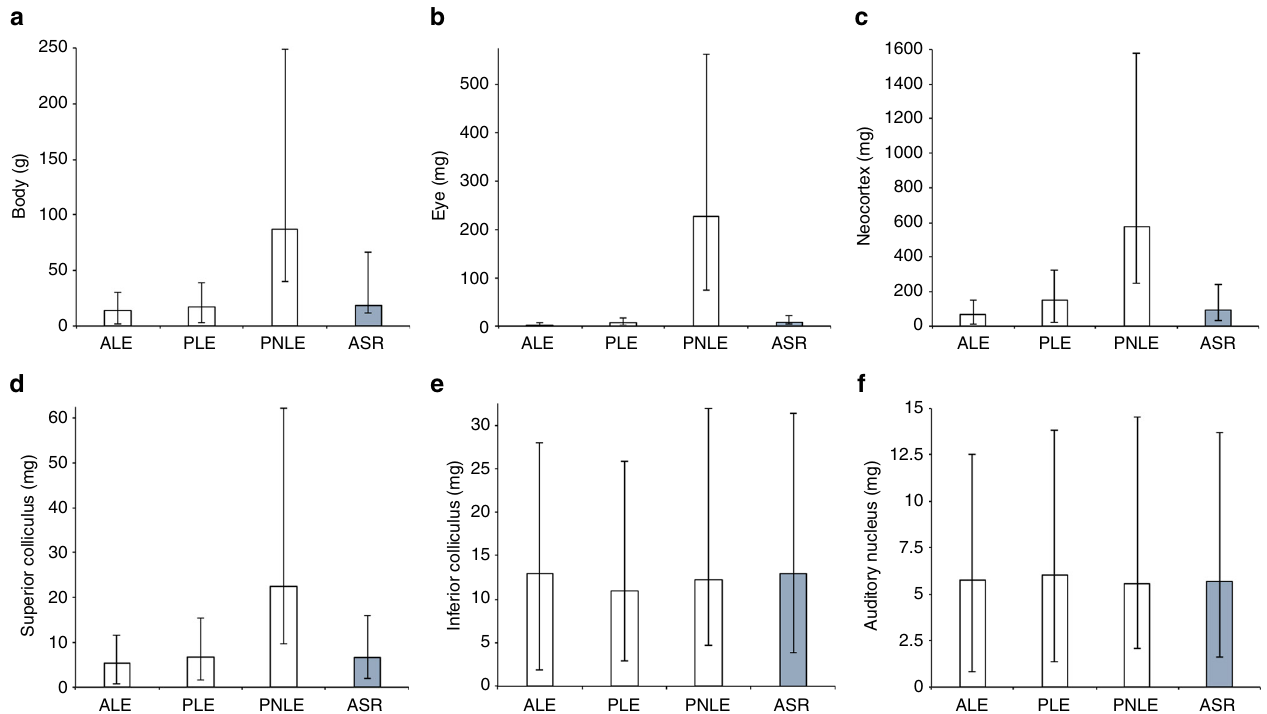
Fig. 3 The ancestral states of bats versus modern foraging categories. The ancestral states (maximum likelihood estimate of the root node) of six continuous traits considered in this study are shown with 95% con fi dence intervals. The tree was re-rooted at each internal nodes and contrasts state at the root was computed each time. AS estimate at the root compared to extant foraging categories for: a body mass ( N = 183), b eye mass ( N = 183), c neocortex mass ( N = 149), d superior colliculus mass ( N = 84), e inferior colliculus mass ( N = 84), and f auditory nucleus mass ( N = 84). The ancestral state range of eye mass and non-auditory brain regions ( b-d ) suggest an increase in pteropodids, while those of the auditory regions ( e , f ) suggest a basic auditory brain design has been conserved in all bats. We found that the auditory regions (i.e., inferior colliculus, auditory nucleus) were the only brain regions that did not differ between the ancestral bat and today ’ s species (see also Supplementary Fig. 1), supporting the notion that the ancestral bat